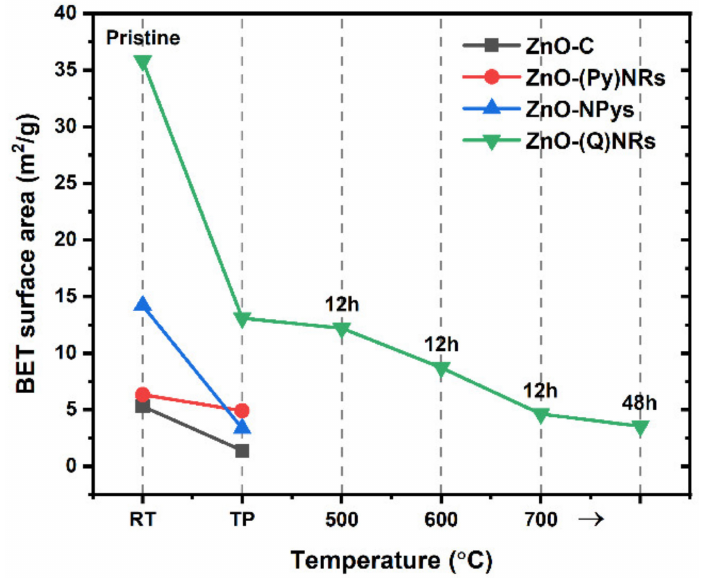
Figure 10. Variation of the surface area of ZnO catalysts at pristine, after temperature program (TP) from 400 ◦ C to 700 ◦ C, and after time on stream (TOS) reactions at 500 ◦ C, 600 ◦ C, and 700 ◦ C. Table 4. T 50 , T 90 temperature values and conversion at 650 ◦ C for the ZnO-based nanomaterials.